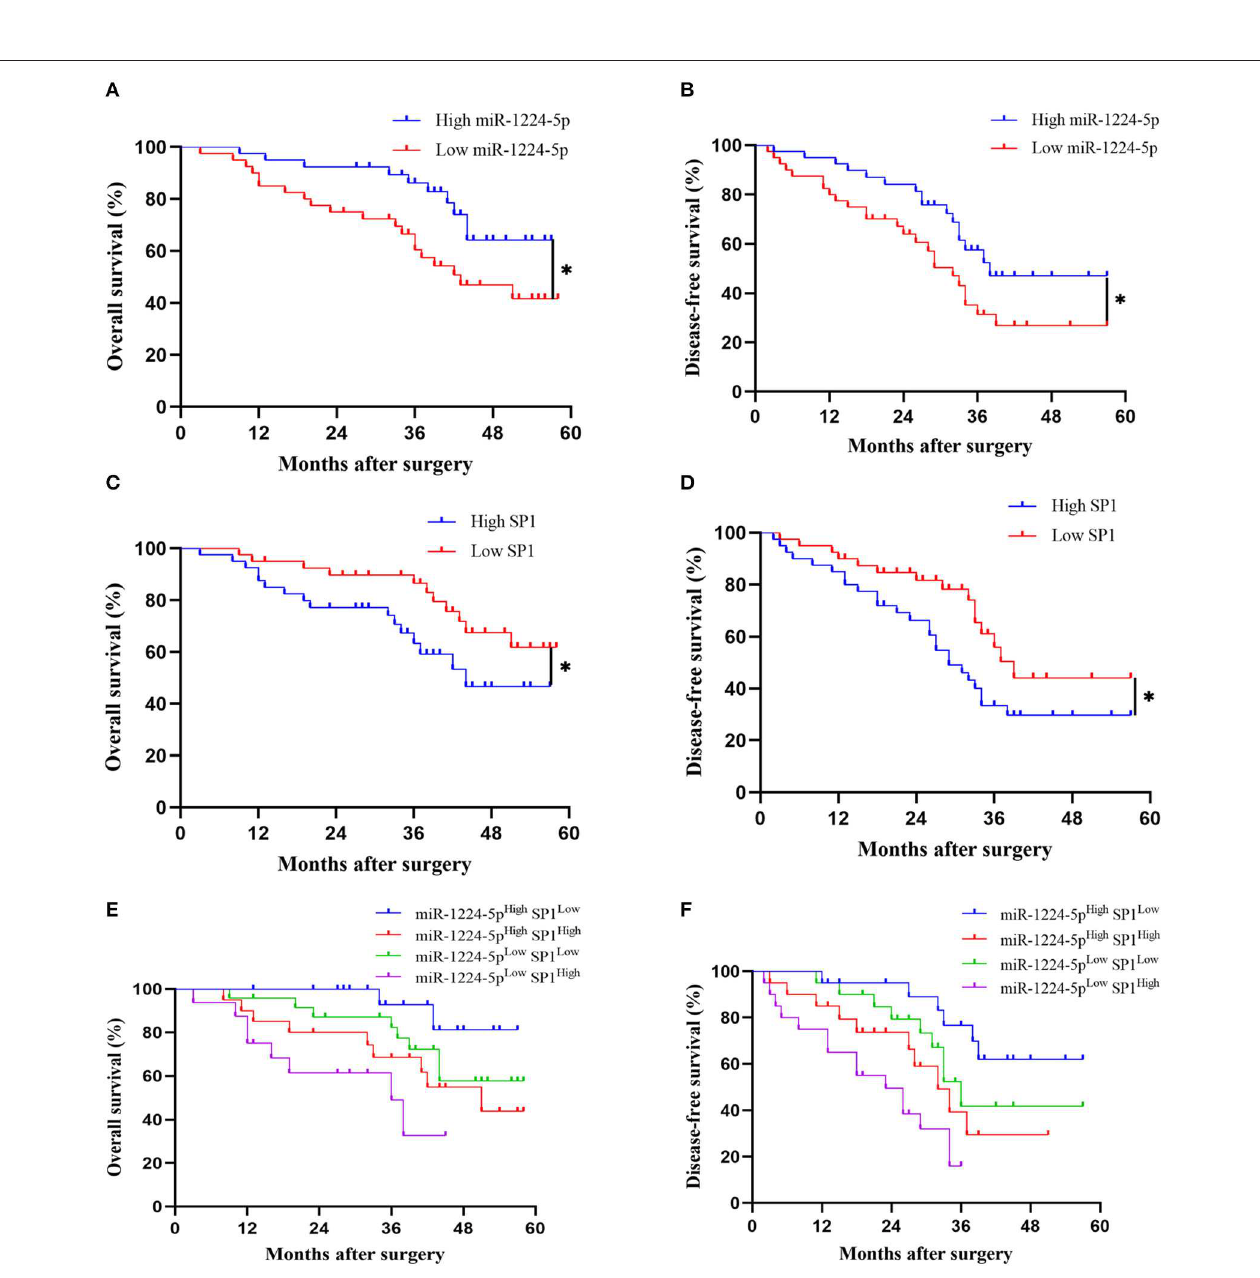
FIGURE 8 | treatment abrogated the effect of miR-1224-5p loss on mobility of HCT116 and SW480 cells, scale bars: 50 µ m (B) 100 µ m (C,D) Western blot analysis indicated that modulating p65 phosphorylation reversed the effects of miR-1224-5p alteration on EMT process of CRC cells. (E) Expression of protein in co-transfected and transfected CRC cells was detected by western blot. (F) I κ B α , phosphorylated I κ B α , p65 and phosphorylated p65 protein levels in whole cell lysate, cytosol and nucleus were analyzed by Western blot. Data represent the mean ± SD from three independent experiments. Student’s t -test was used to determine statistical significance: * p < 0.05, *** p < 0.001.